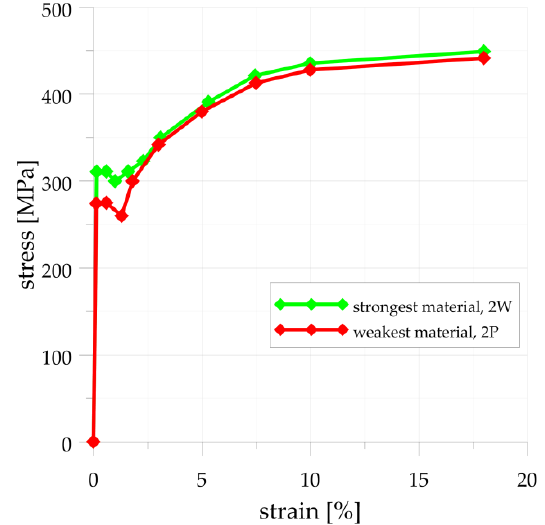
Figure 8. Stress–strain curves implemented for numerical analyses in Section 3.1.